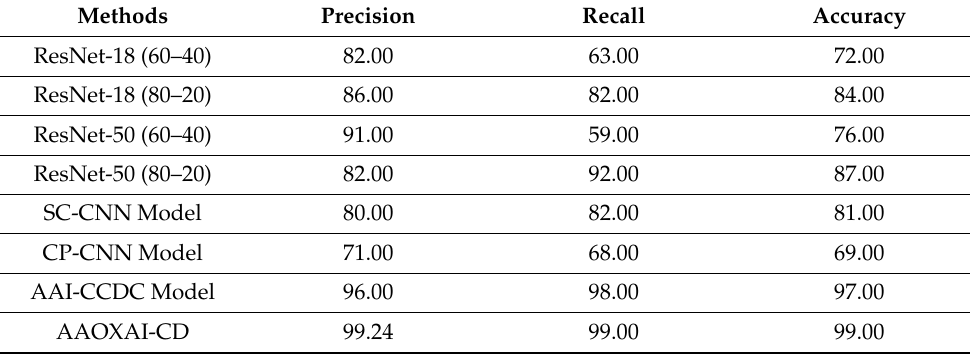
Table 2. Analysis outcome of AAOXAI-CD method with other systems on dataset-1.